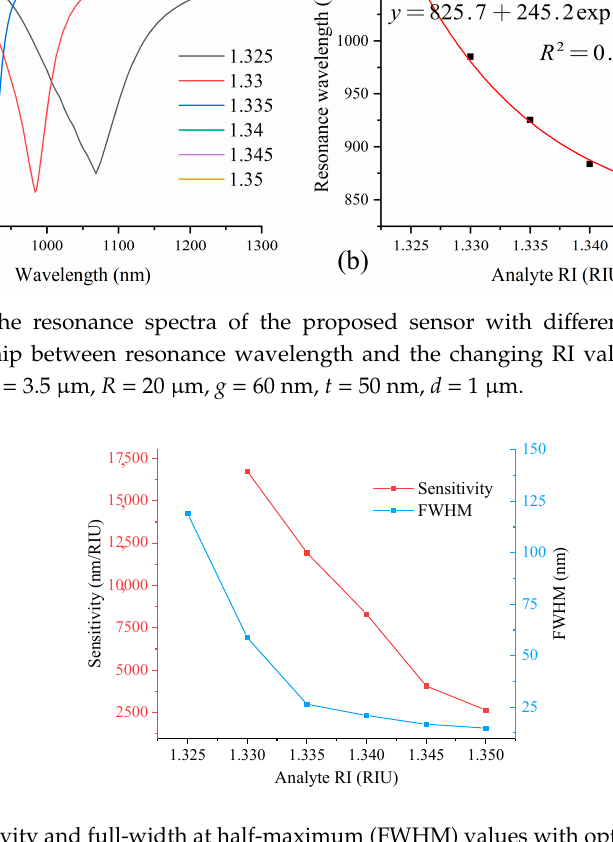
Figure 10. Sensitivity and full-width at half-maximum (FWHM) values with optimized parameters in the RI range of 1.325 to 1.35. Table 1. Optimized parameters for our design.